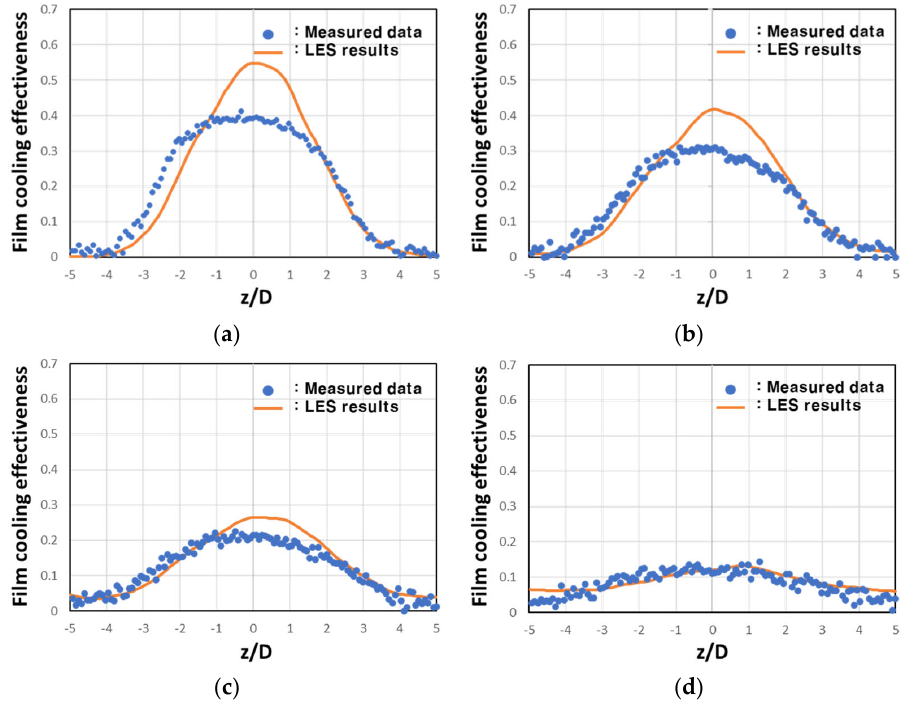
Figure 14. Lateral film cooling effectiveness distributions at ( a ) x/D = 2, ( b ) x/D = 5, ( c ) x/D = 10, and ( d ) x/D = 20 when the blowing ratio is 1.0.